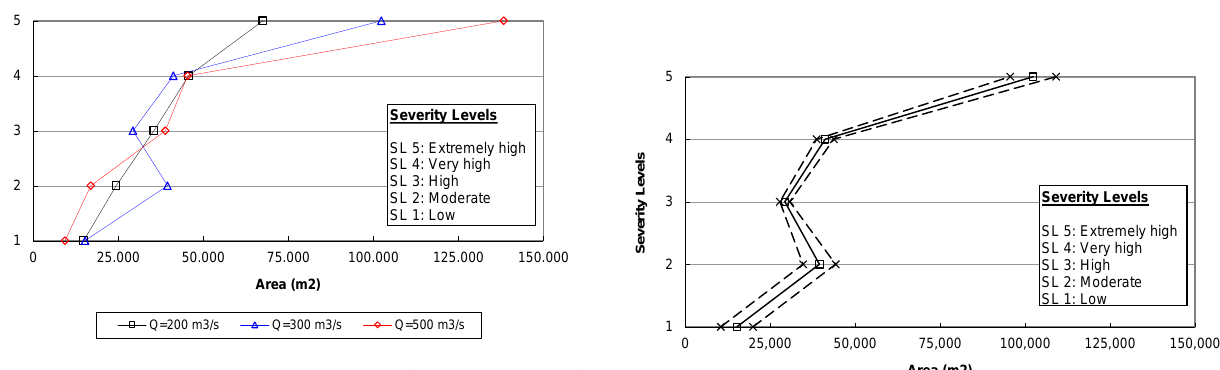
Fig. 19. 2-D SWE model. Expected values of the extension of areas with different severity levels for flow cases 200, 300 and 500m 3 s − 1 .